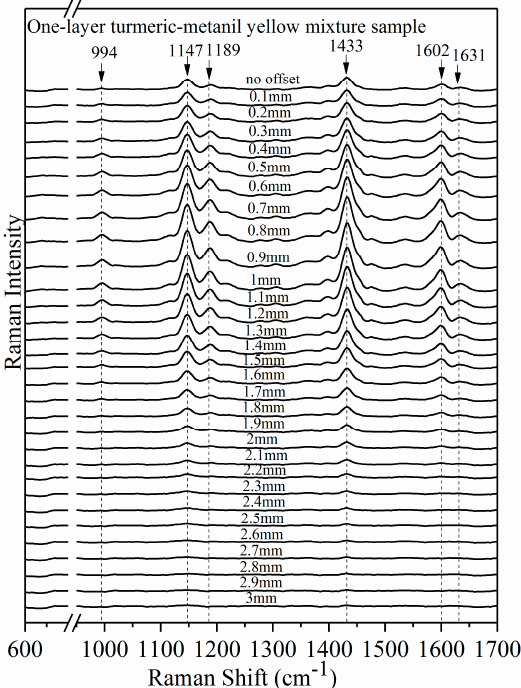
Figure 11. Spatially offset Raman spectra of turmeric-metanil yellow mixture packaged inside one-layer capsule.